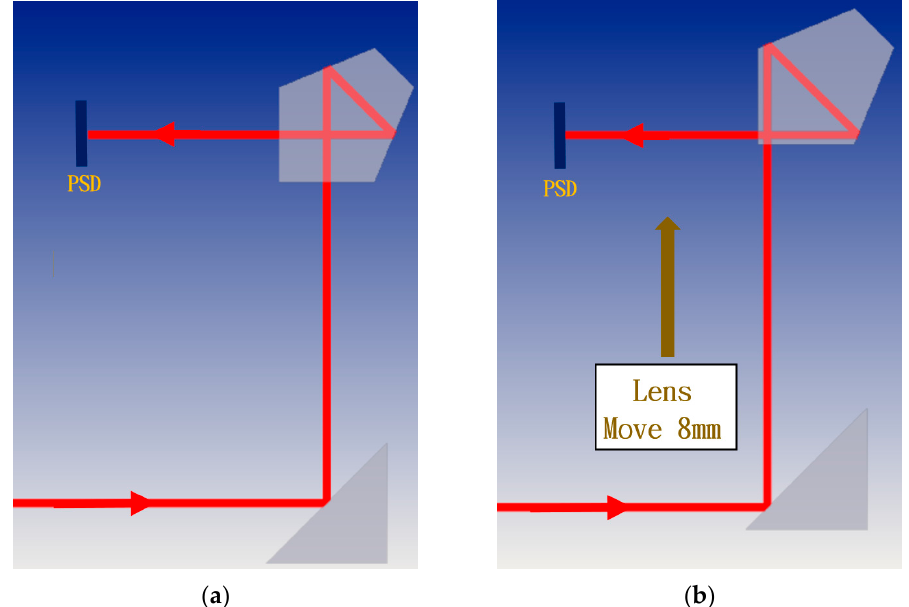
Figure 2. Light path with mirror and penta prism: (a) before and (b) after mirror’s movement.